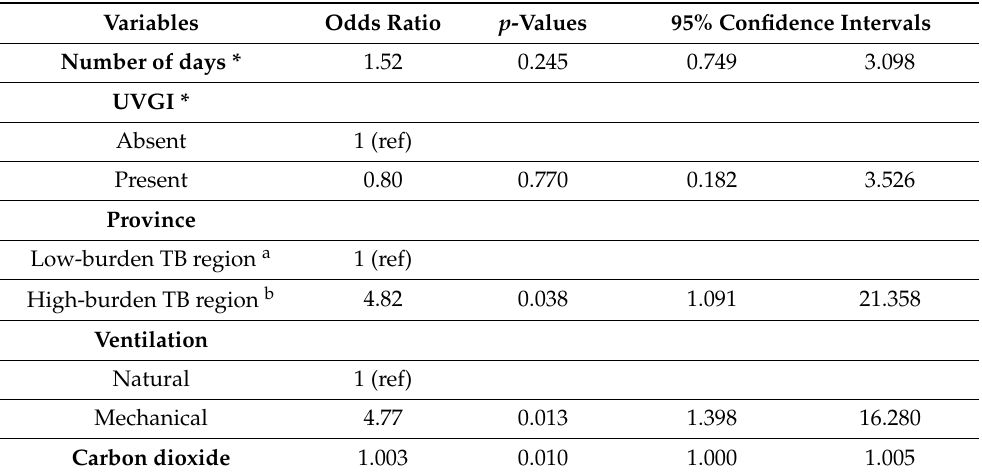
Table 5. Factors associated with airborne M. tuberculosis exposure in healthcare